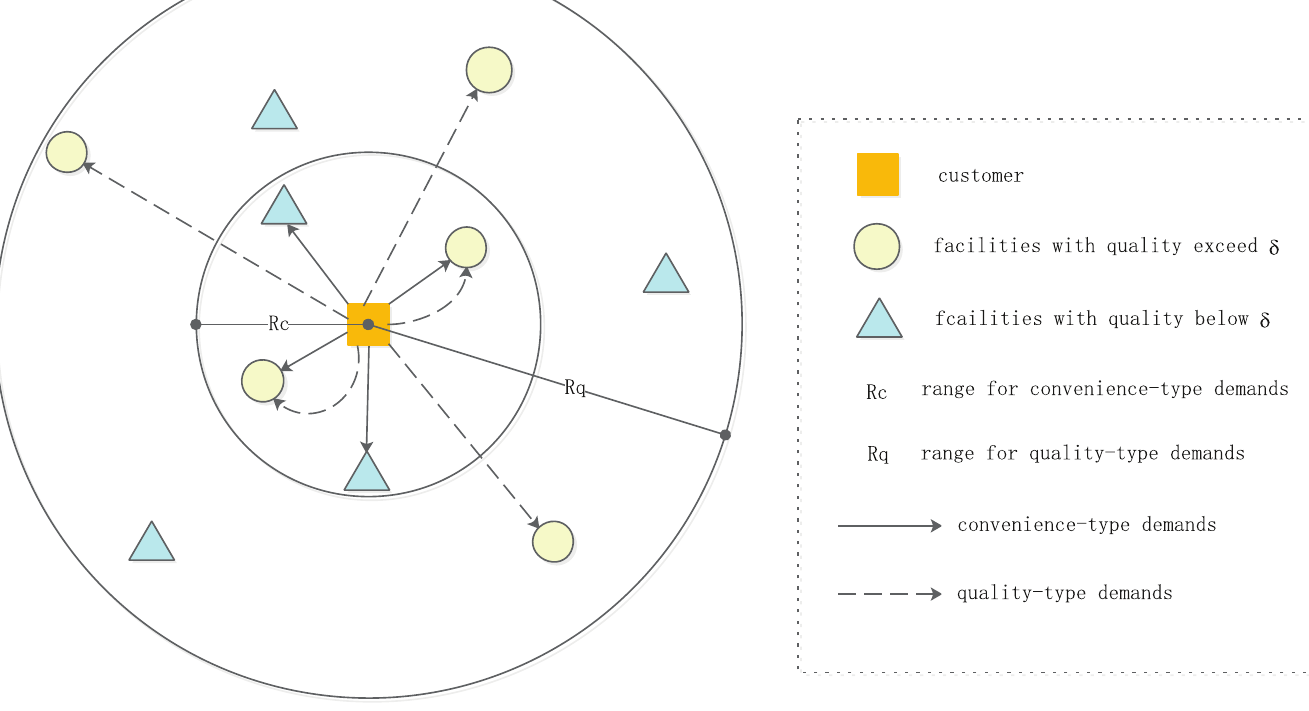
Fig 1. Patronage pattern from the perspective of